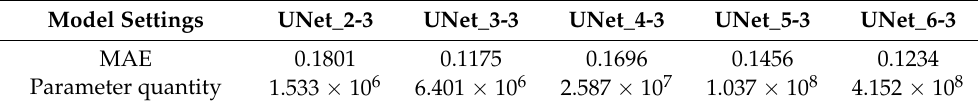
Table 3. Model performance comparison—number of